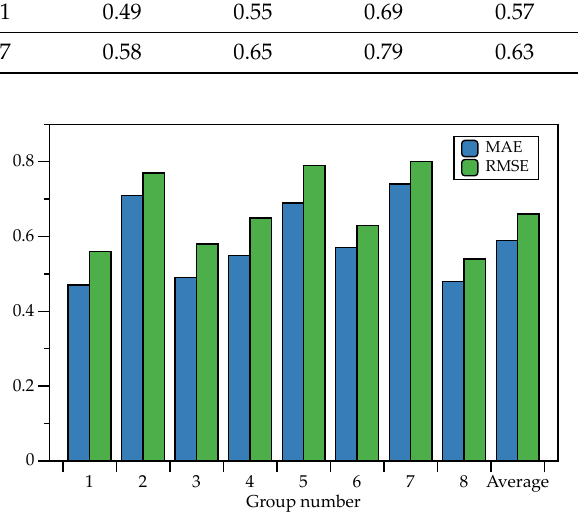
Table 6. Comparison with other similar works.